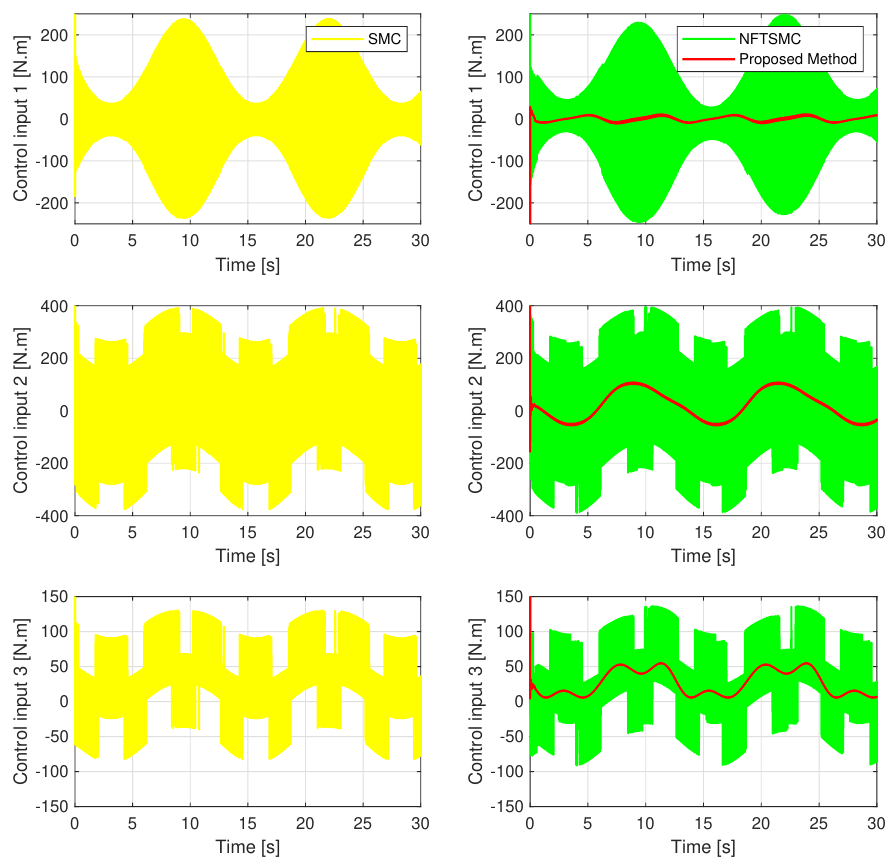
Figure 10. Comparison of the control torques from three